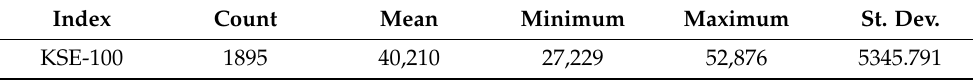
Figure 4. The daily closing price of the KSE-100 index. Table 1. Descriptive statistics of KSE-100 index daily closing